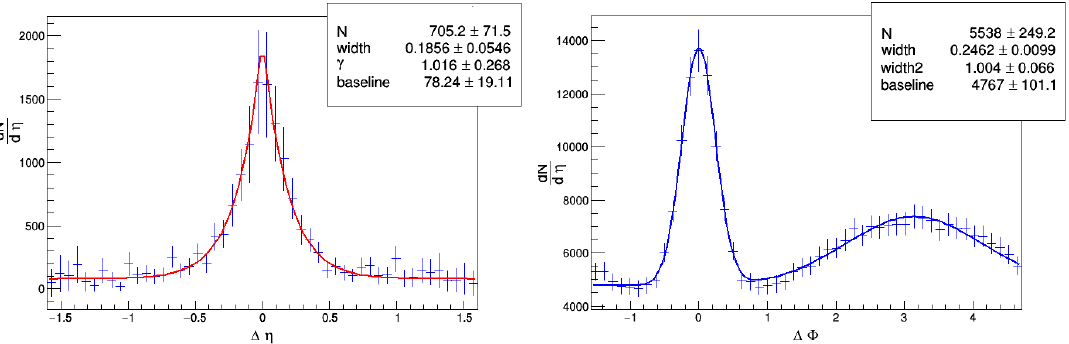
Figure 1. The peak in ∆ η with near-side cut (| ∆Φ | < π /2) of light charged hadrons with generalized Gaussian fitting (on the left side) and the near-and away-side peaks of light charged hadrons in ∆ ϕ plane with Gaussian fitting (on the right